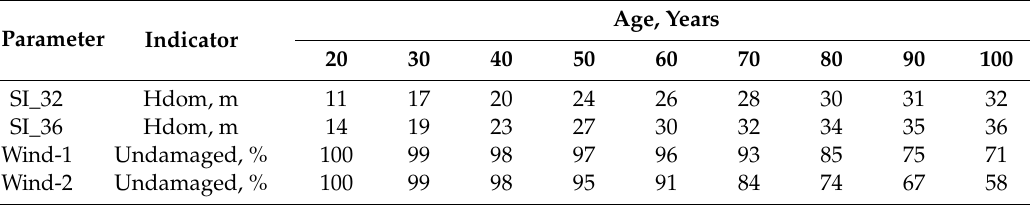
Table 1. Height growth and mean proportion of stands una ff ected by wind. Parameter